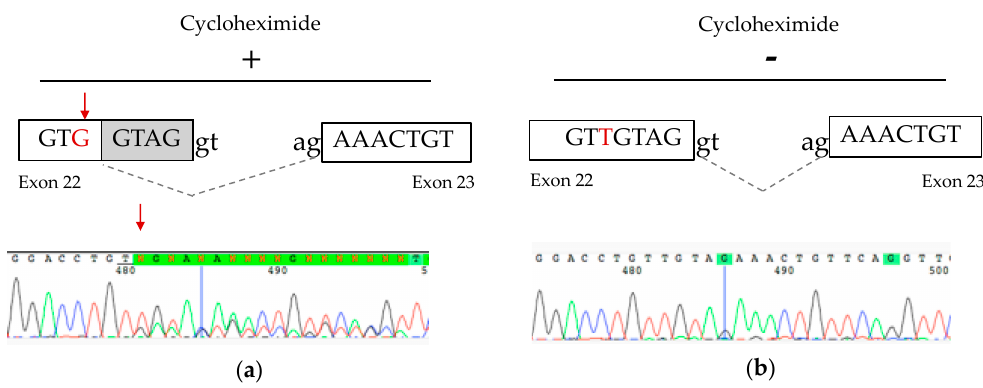
Figure 3. cDNA studies from P2 fibroblast cells. ( a ) Schematic representation and partial electropherogram showing the creation of a new splice site generated by the NM_033109.4:c.1818T>G variant in cells treated with cycloheximide. ( b ) Without cycloheximide treatment, the heterozygous NM_033109.4:c.1818T>G variant was not detectable, suggesting that the mutant RNA is subject to nonsense-mediated decay.